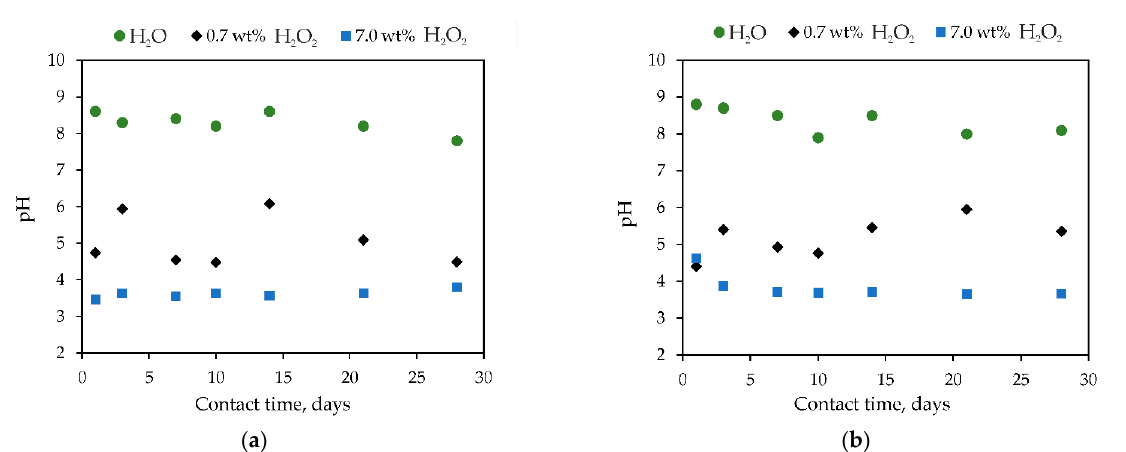
Figure 3. The pH values of solutions after leaching ( a ) initial samples of NAFP glass and ( b ) samples after heat treatment at 450 °C.